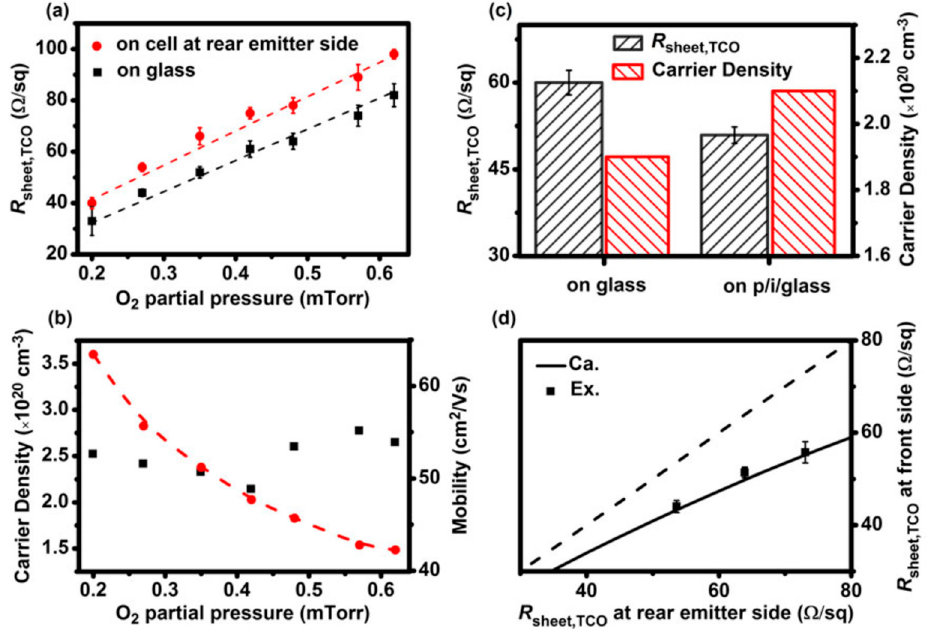
Figure 5. The deviations of ( a ) TCO sheet resistance measured on glass and at the rear side of the cell, ( b ) oxygen partial pressure as a function of mobility and carrier density of the TCO films. ( c ) Comparison of carrier density and TCO sheet resistance attained on glass and p/i/glass substrates after annealing treatment at 200 °C for 30 min. ( d ) Correlation between the R sheet of the TCO meas- ured at the front side and rear side of the cell [84]. (Reprinted with permission from ref. [84]; copy- right form Wiley order number 5492920290840.)